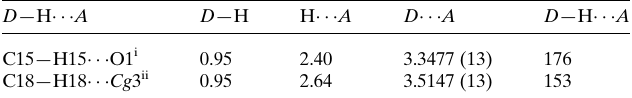
Table 3 Hydrogen-bond geometry (A˚ , (cid:2) ) for (III).